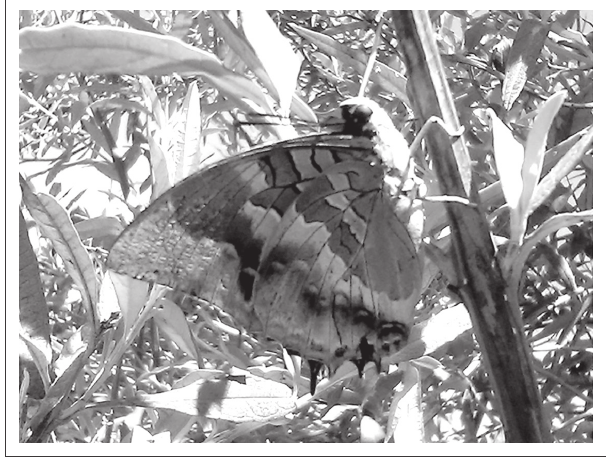
Source : Photo taken by Casparus J. Crous FIGURE 4: A male Charaxes xiphares occidentalis individual feeding on the stem sap of a non-forest inhabiting Buddleja saligna tree.